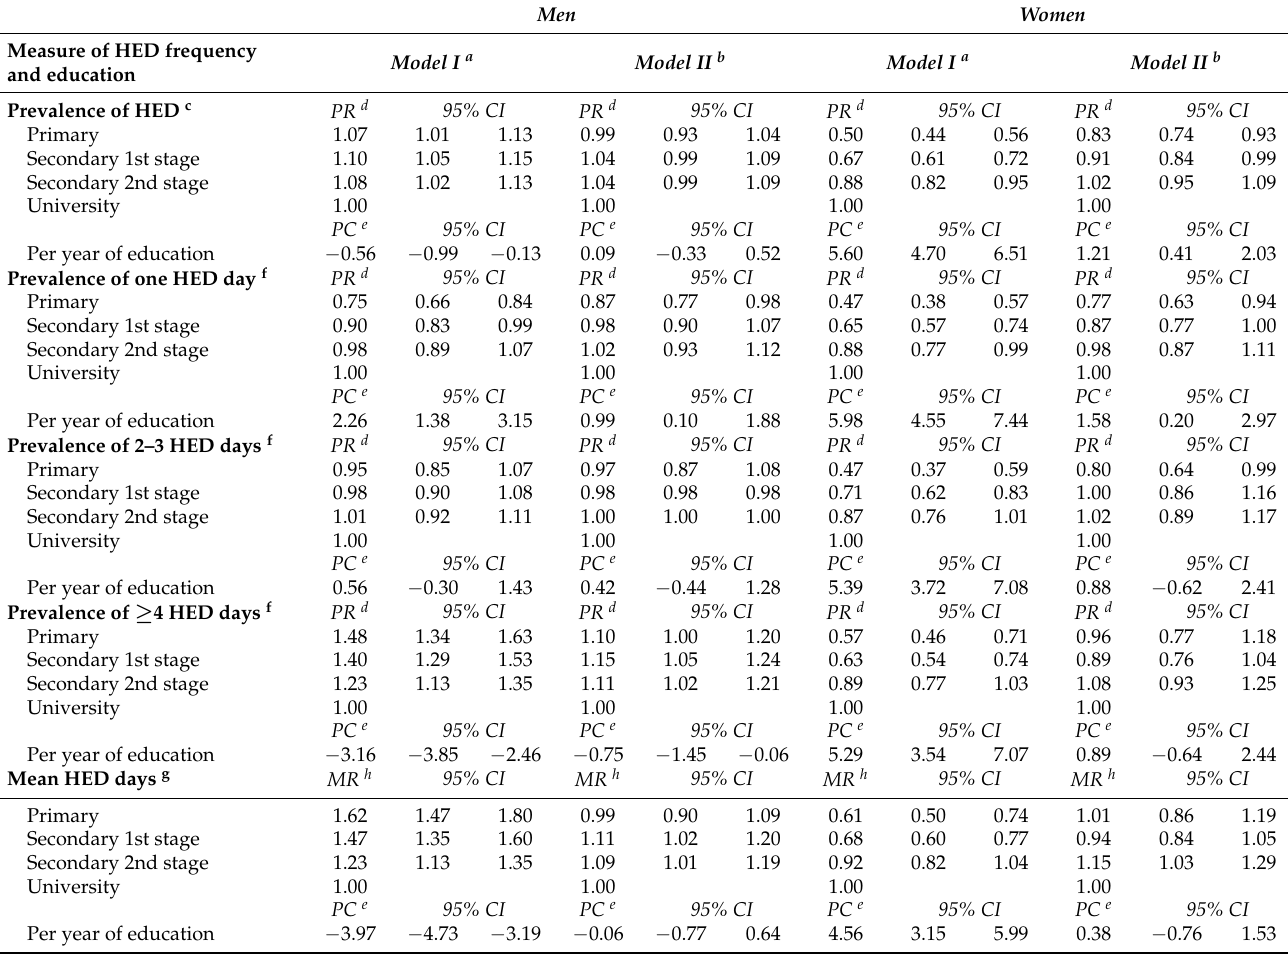
Table 3. Educational inequality in five measures of frequency of heavy episodic drinking (HED) in the last 30 days among people aged 25–64 by sex, Spain